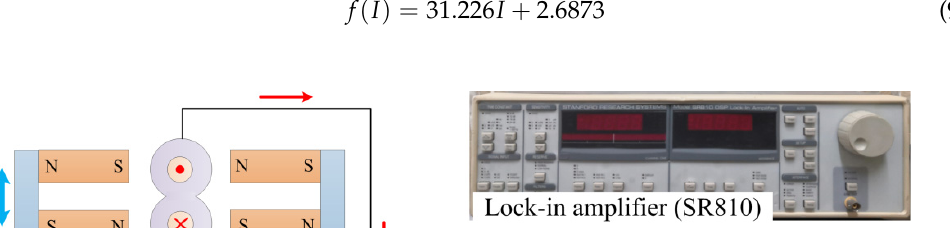
Figure 4. Experimental set-up for 50 Hz current sensing experiments.